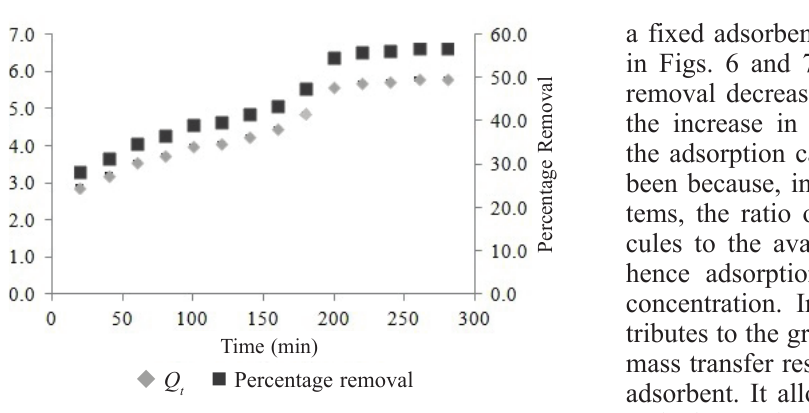
Fig. 4 – Adsorption rate curve of Reactive Green 19 (initial dye concentration = 200 mg L –1 ; adsorbent dosage = 1.0 g/50